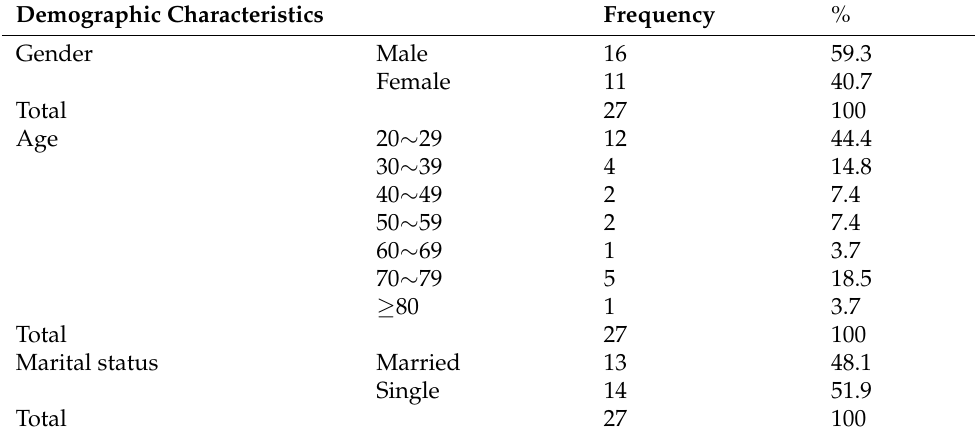
Table 2. Demographic characteristics of the participants in the experimental evaluations.